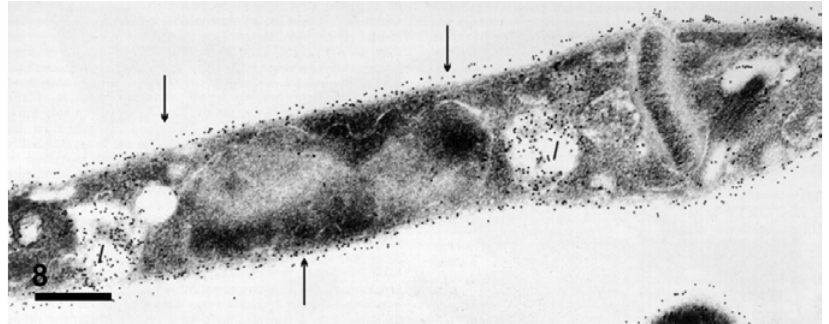
Fig. 8 – Immunocytochemical localization of cysteine proteinase in epimastigotes of Trypanosoma cruzi . This protein is synthesized in the ER and concentrated in structures which are part of the endocytic pathway of this protozoan (asterisks) and in the plasma membrane (arrows). Bar, 0 . 5 µ m. After Souto-Padrón et al.